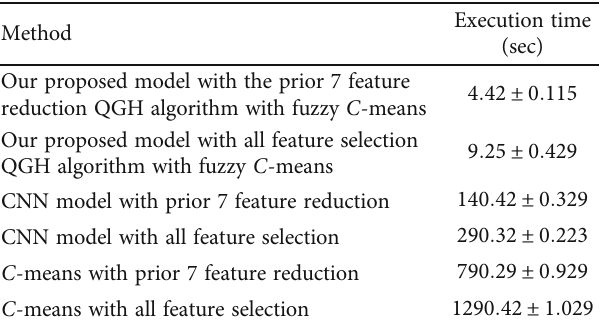
Table 7: Comparison of the classi fi cation time in